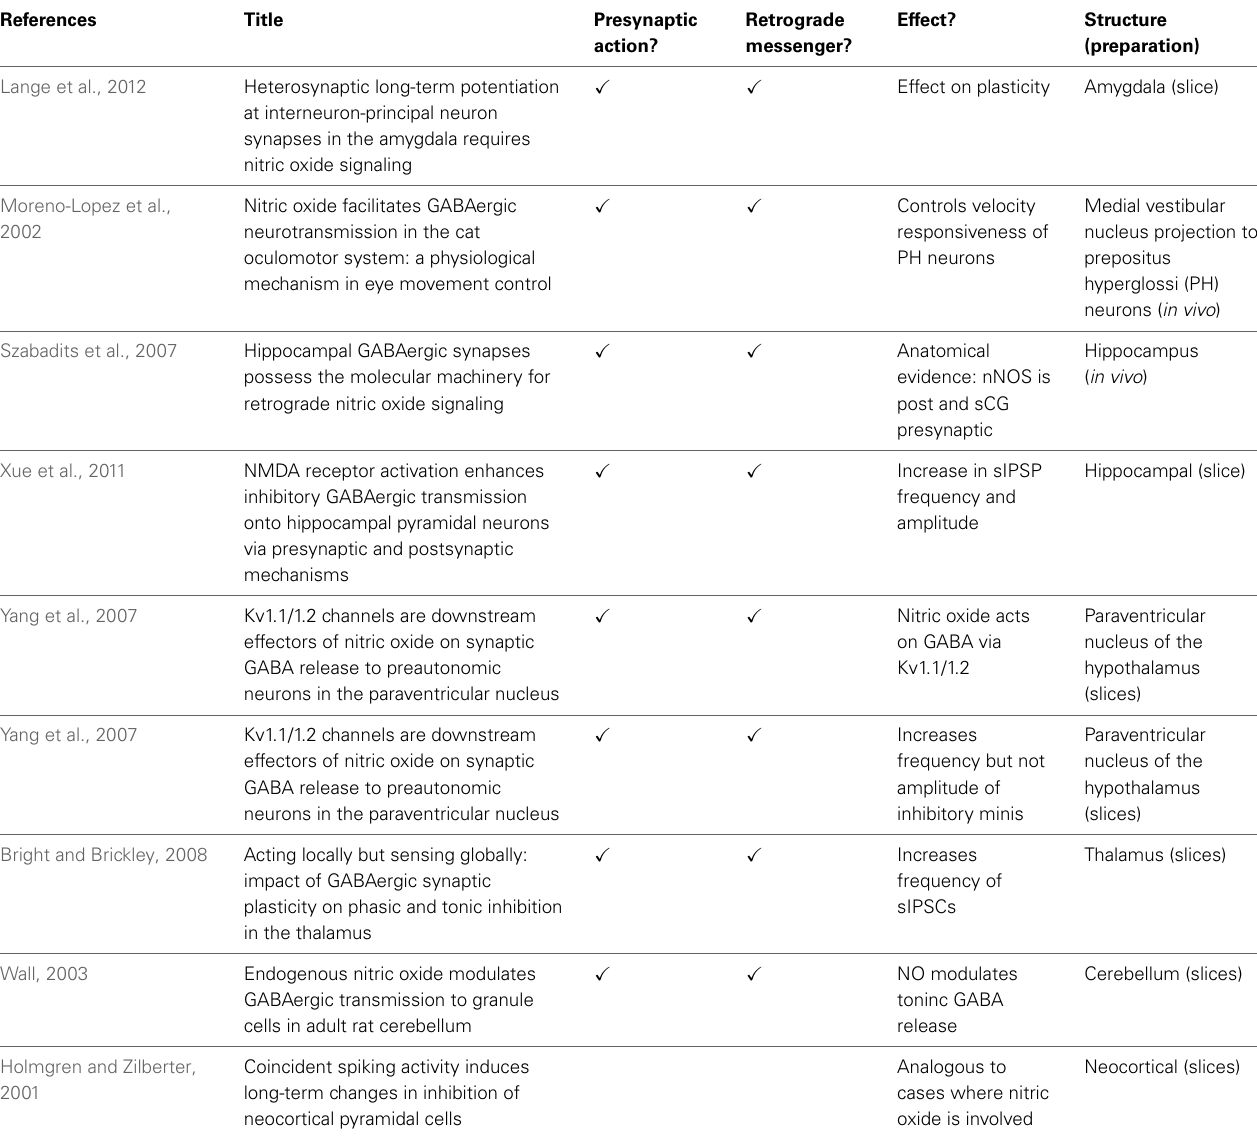
Table 2 | The role of Nitric oxide in GABAergic